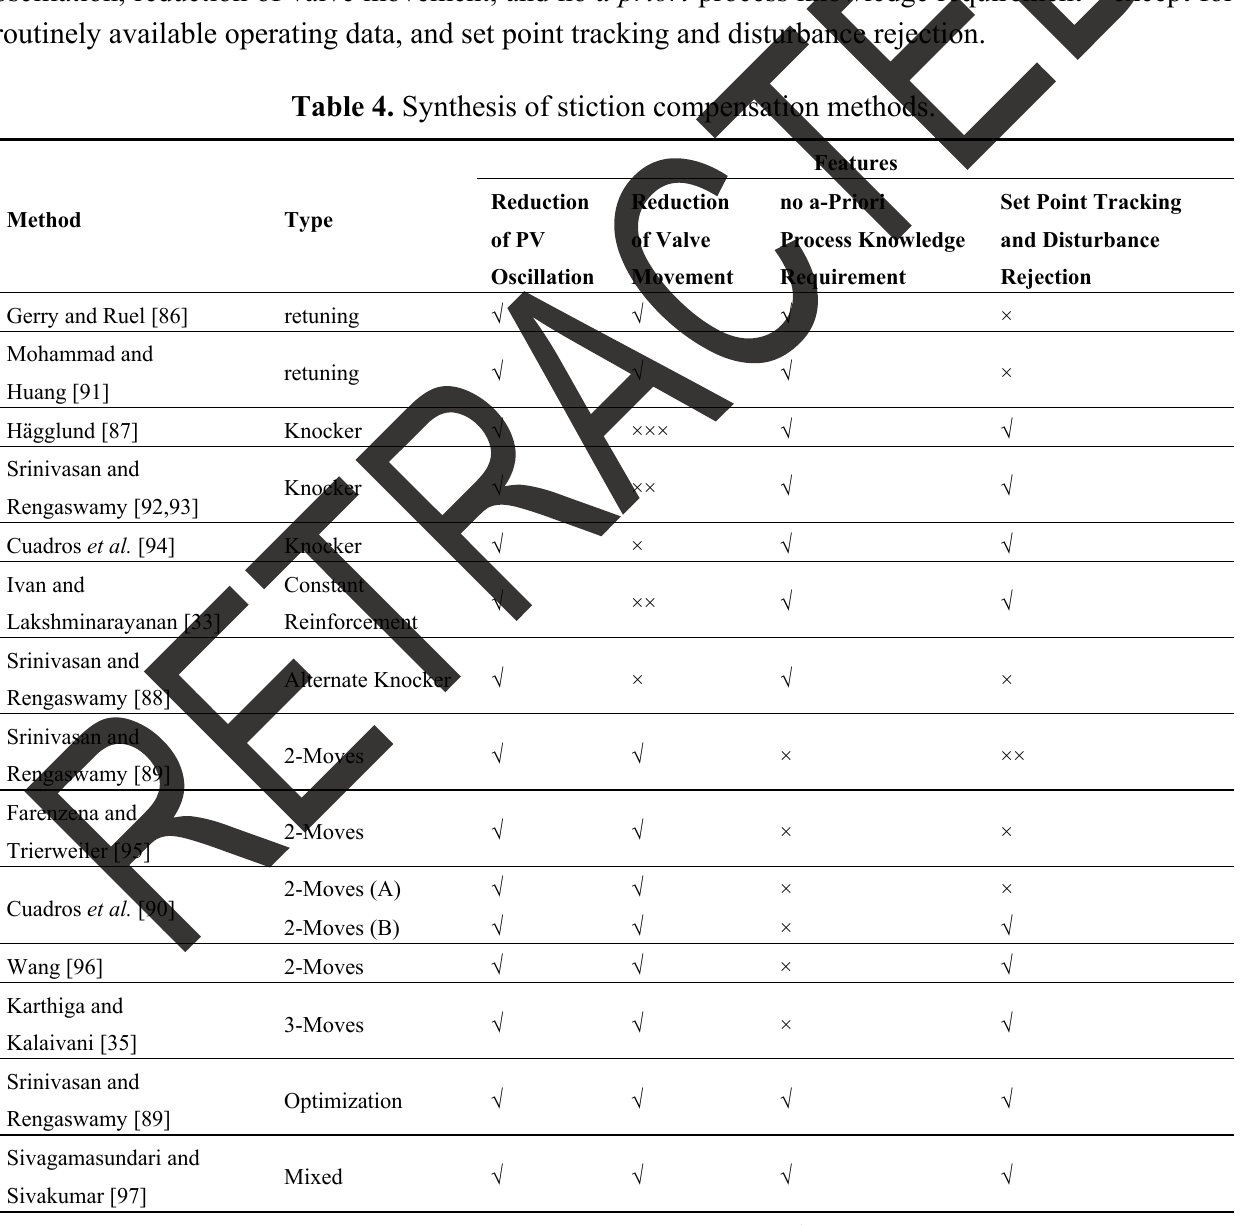
Table 4. Synthesis of stiction compensation